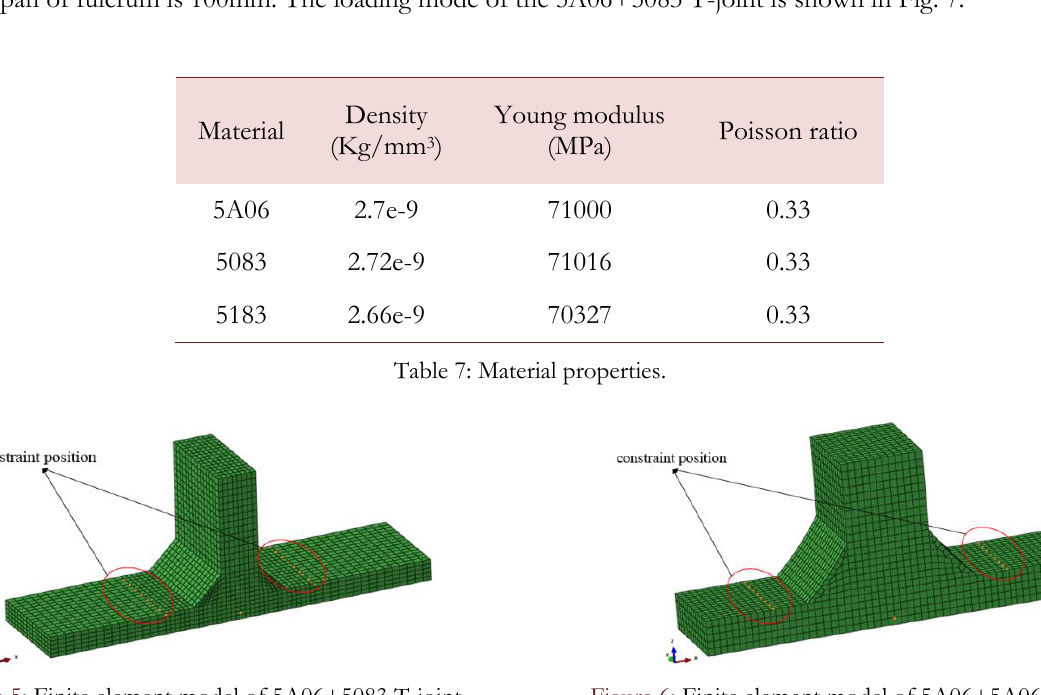
Figure 5: Finite element model of 5A06+5083 T-joint. Figure 6: Finite element model of 5A06+5A06 T-joint.